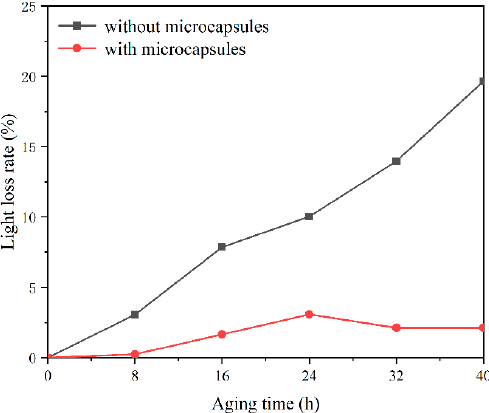
Figure 9. Influence of time on light loss rate of coating at 120 °C in oven.